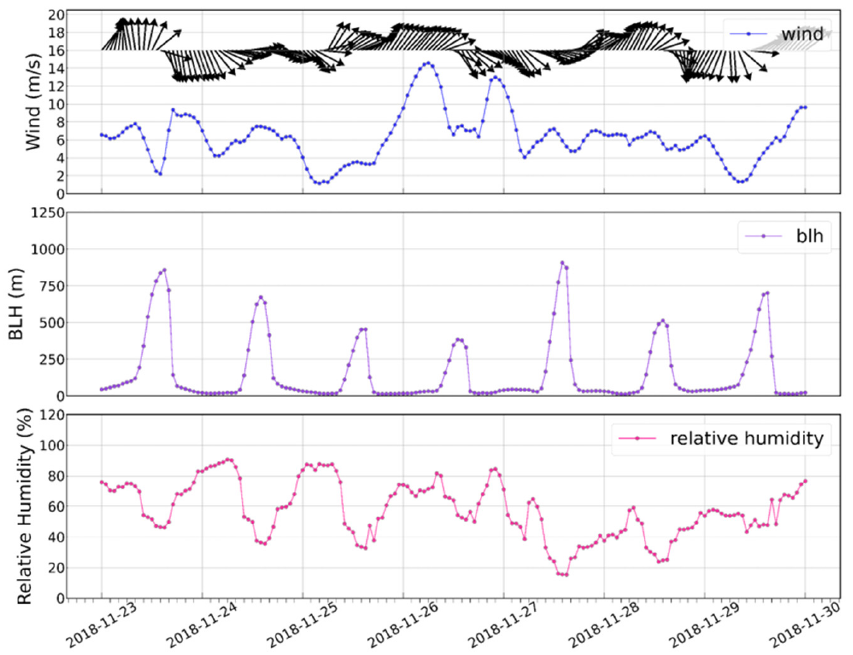
Figure 10. ERA-5 meteorological data including wind direction, wind speed, boundary layer height, surface relative humidity at Gucheng from 23 to 30 November 2018. Note that wind variables are at an altitude level of 925 hPa. Phase I (haze): from 23 November 4 p.m. to 25 November at 6 p.m., due to the high relative humidity during this period and the continuous decrease in wind speed and boundary layer height, resulting in increasing pollution near the ground. PM 2.5 concentrations increased slowly during this period, but AOD did not change